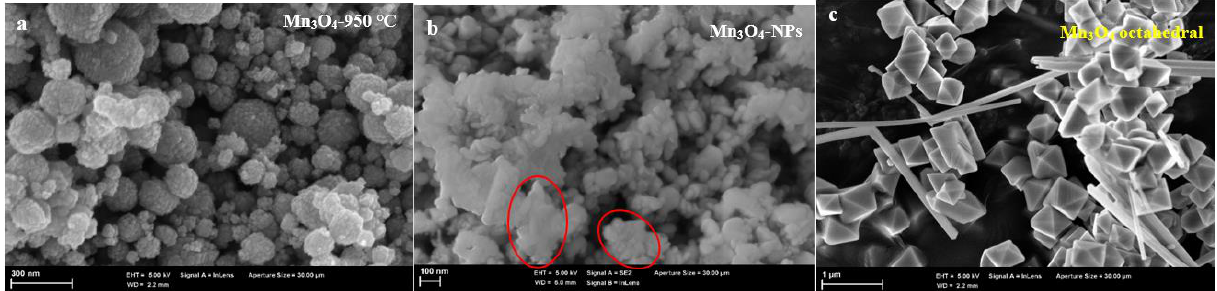
Figure 3. Morphology of ( a ) Mn 3 O 4 950 °C ( b ) Mn 3 O 4 NPs ( c ) octahedral Mn 3 O 4 catalysts.